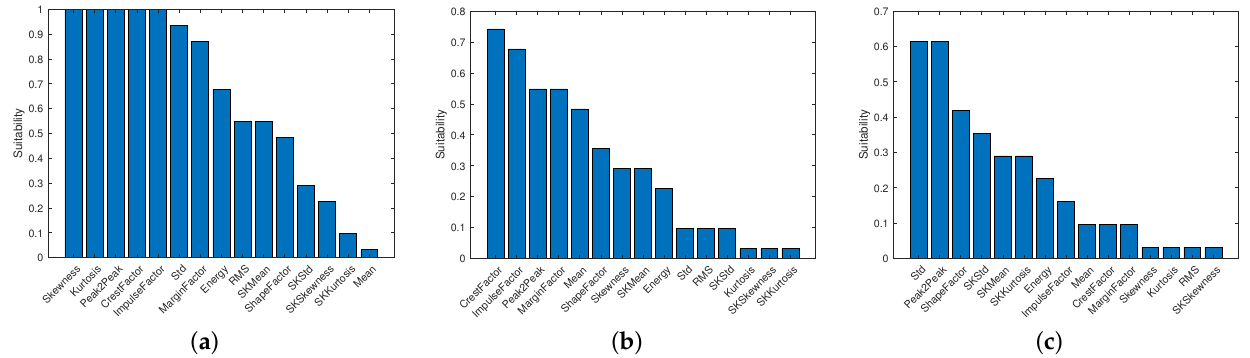
Figure 6. Suitability of the extracted features, ( a ) torque signals, ( b ) stator current signals, and ( c ) speed